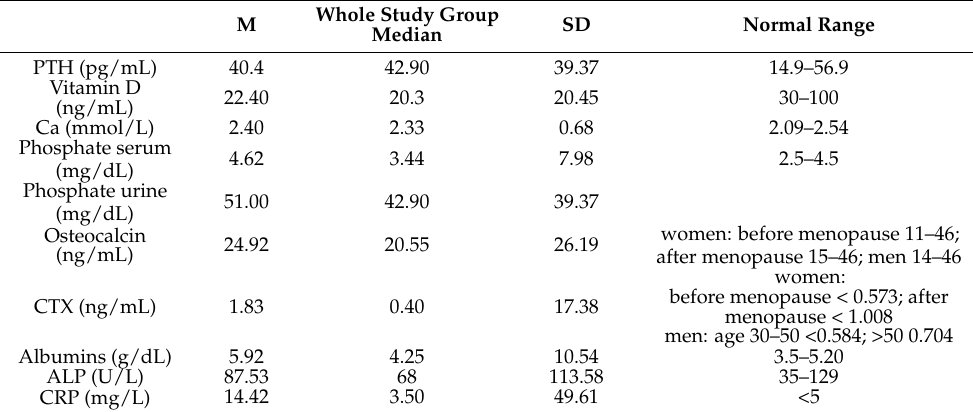
Table 2. Baseline assessment of calcium-phosphate metabolism indicators in the whole study